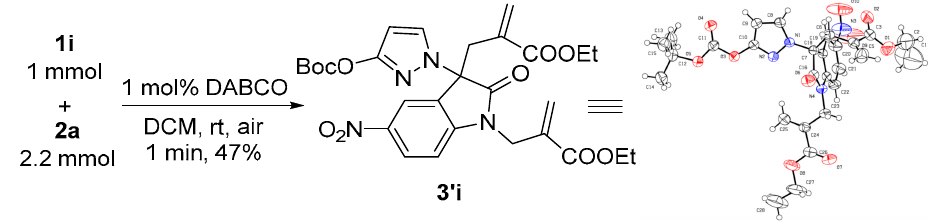
Table 3. Synthesis of N -allylated products 6 from isatin N , N ′ -cyclic azomethine imine 1 and MBH carbonates 5 a .